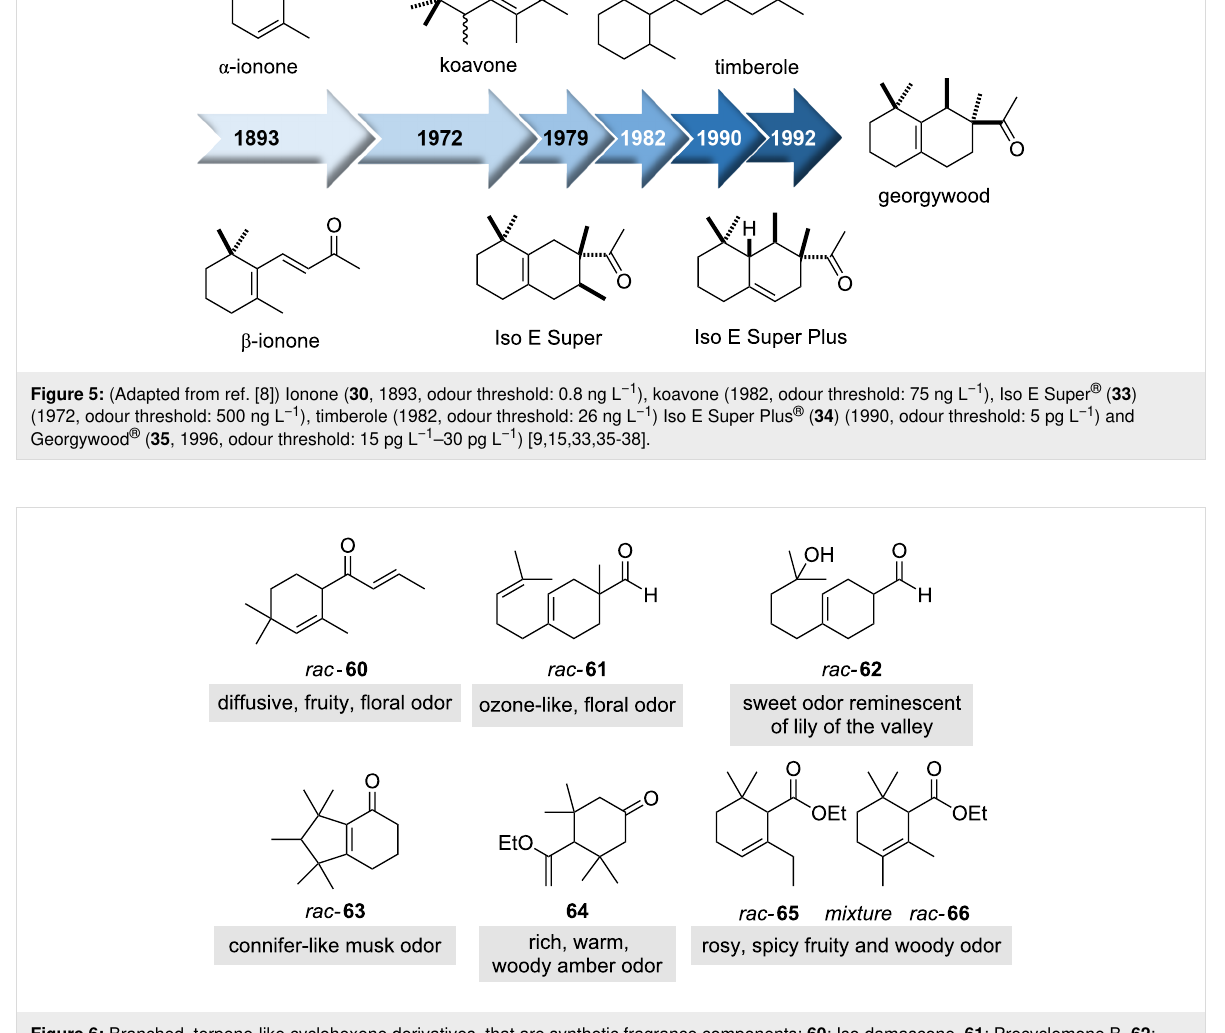
Figure 6: Branched, terpene-like cyclohexene derivatives, that are synthetic fragrance components: 60 : Iso damascone, 61 : Precyclemone B, 62 : Lyral ® , 63 : Cashmeran ® , 64 : Kephalis, and 65 , 66 : Givescone ®